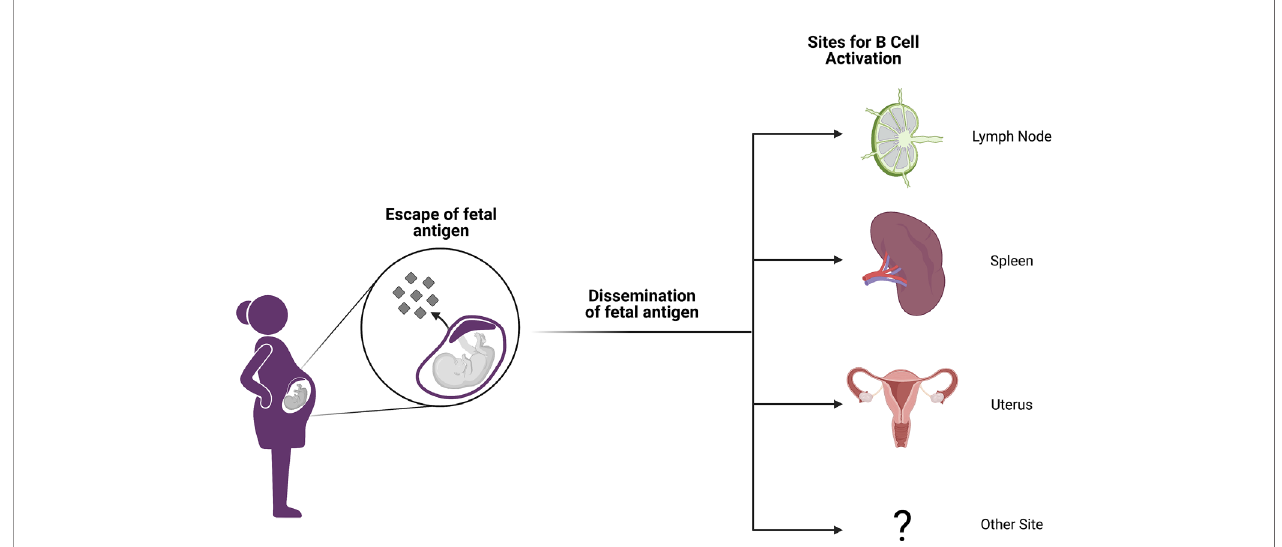
FIGURE 1 | Anatomic sites of alloimmunization in pregnancy. Although fetal antigen is known to disseminate widely, it is not well understood at which sites B and T cell priming take place in allosensitization. Candidate locations include secondary lymphoid organs (SLOs) like lymph nodes and spleen. However, it is also possible that immune structures within the gravid uterus may host alloantigen encounters or perhaps other anatomic sites are involved. Figure created with